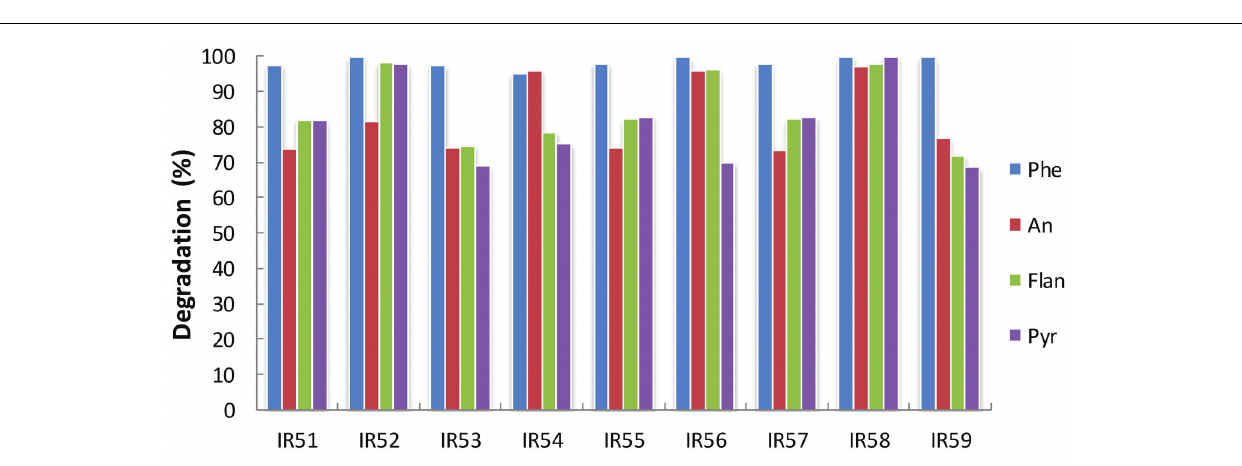
FIGURE 2 | Degradation of the 4-PAH mixture by nine consortia from the deep sea water column of the Indian Ocean. PAH degradation experiments were conducted in 100 ml Erlenmeyer flasks containing 30 ml NH medium with a mixture of 4-PAHs as carbon sources (using the same concentrations in